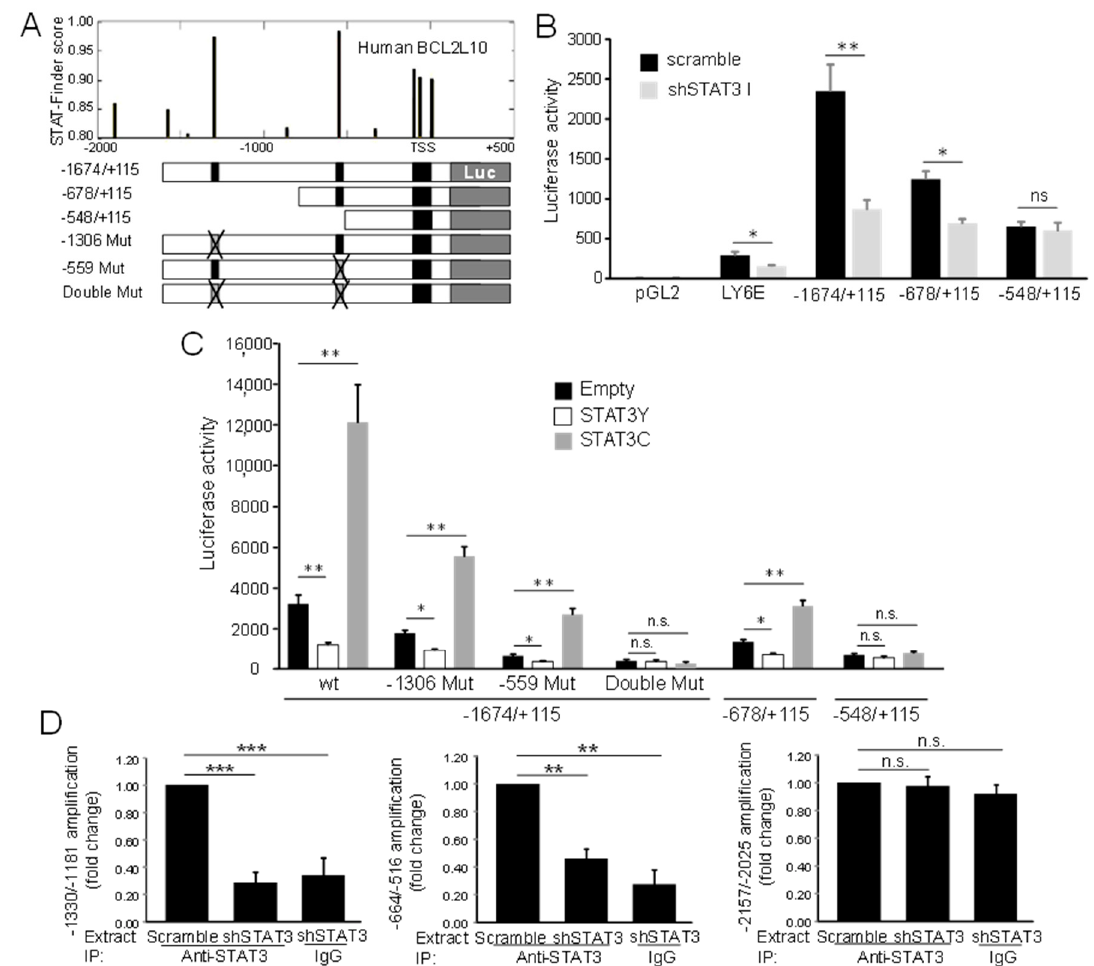
Figure 4. STAT3 binds to the BCL2L10 promoter and regulates its transcription. ( A ) Structure of the proximal region of the human BCL2L10 promoter. Putative STAT3 responsive elements (above) and fragments of the promoter that were cloned into pGL2 (below) are depicted. The sites at − 1306 and − 559 were deleted by site-directed mutagenesis, generating two plasmids with a single mutation and one plasmid with a double mutation. ( B ) Silencing of STAT3 diminished the reporter activity of the BCL2L10 promoter. The indicated reporter plasmids were transfected into UACC903-shSTAT3 and UACC903-scramble cells. Results are shown as the mean ± SD *: p ˂ 0.05. **: p ˂ 0.01, ns: not significant, n = 3. ( C ) STAT3 enhances BCL2L10 transactivation through the SREs at − 1306 and − 559. The indicated reporter plasmids were transfected into HEK293T cells together with STAT3Y and STAT3C plasmids. Results are shown as the mean ± SD *: p ˂ 0.05, **: p ˂ 0.01, ns: not significant, n = 3. ( D ) STAT3 silencing decreased binding of STAT3 to the BCL2L10 promoter. The plots show the relative level of BCL2L10 amplification (normalized to GAPDH levels) corresponding to region − 1330/ − 1181 (left) and region − 664/ − 516 (center) following a chromatin immunoprecipitation assay on UACC903-scramble and UACC903-shSTAT3 cells. Amplification of region − 2157/ − 2025, used as a negative control, is shown on the right. The fold change compared to the level of amplification observed in UACC903-scramble cells is shown. The mean ± SD from three independent experiments is shown. The statistical analysis is described in Methods. **: p < 0.01 ***: p < 0.001, n = 3. n.s. = not significant.